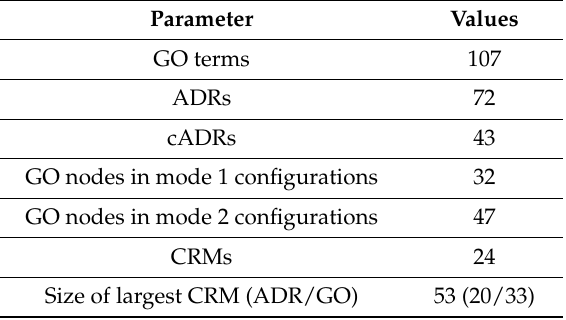
Table 2. Topological parameters of the fluoxetine–phenelzine drug combination network.